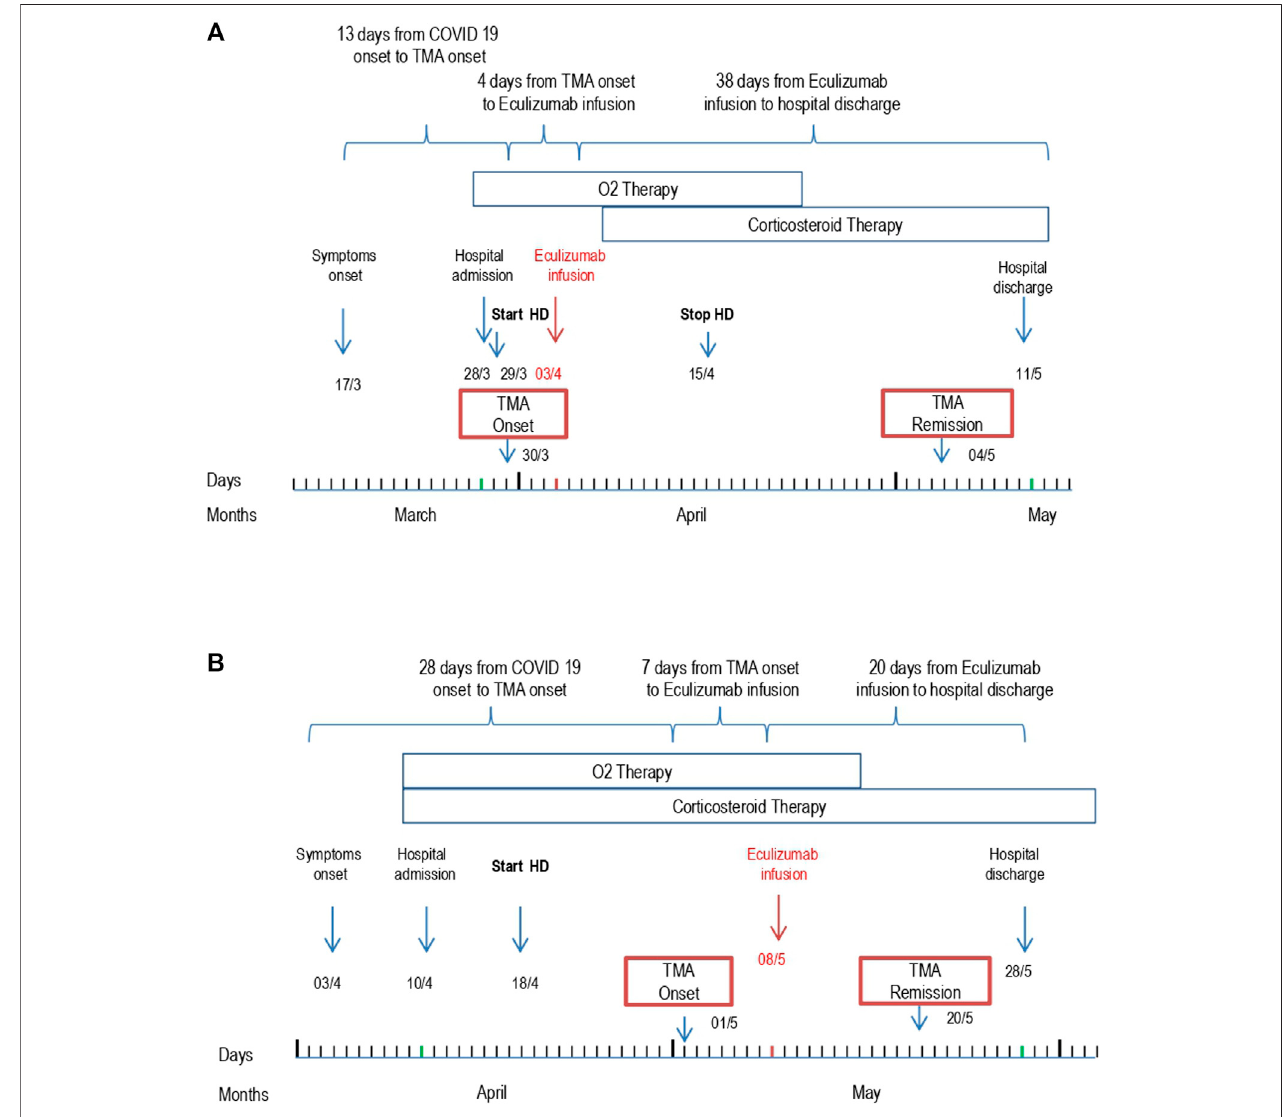
FIGURE 1 | Patient 1 (A) and Patient 2 (B) outcome from symptom onset to hospital discharge. Abbreviations: Thrombotic microangiopathy (TMA); Hemodialysis (HD).